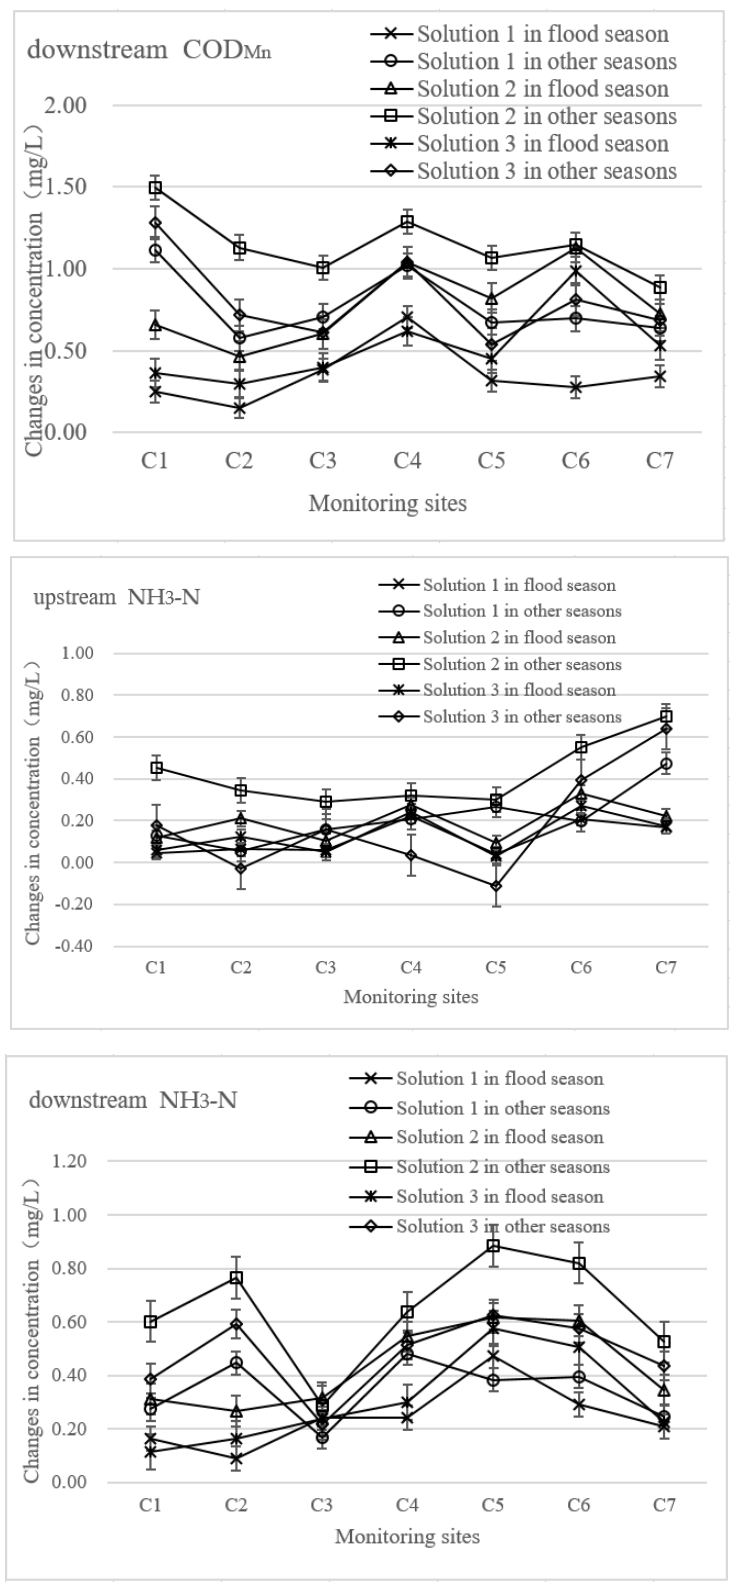
Figure 6. The seasonal changes in COD Mn and NH 3 -N concentrations under different floodgates.